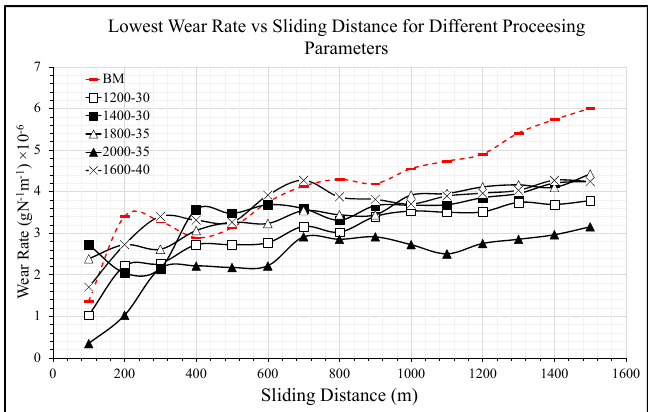
Figure 15. Wear rate vs. sliding distance for FSPed samples with the smallest wear rate produced by different processing parameters under starved lubrication conditions. (Normal contact pressure = 0.24 MPa, sliding speed = 2.88 m/s, total sliding distance = 1500 m).